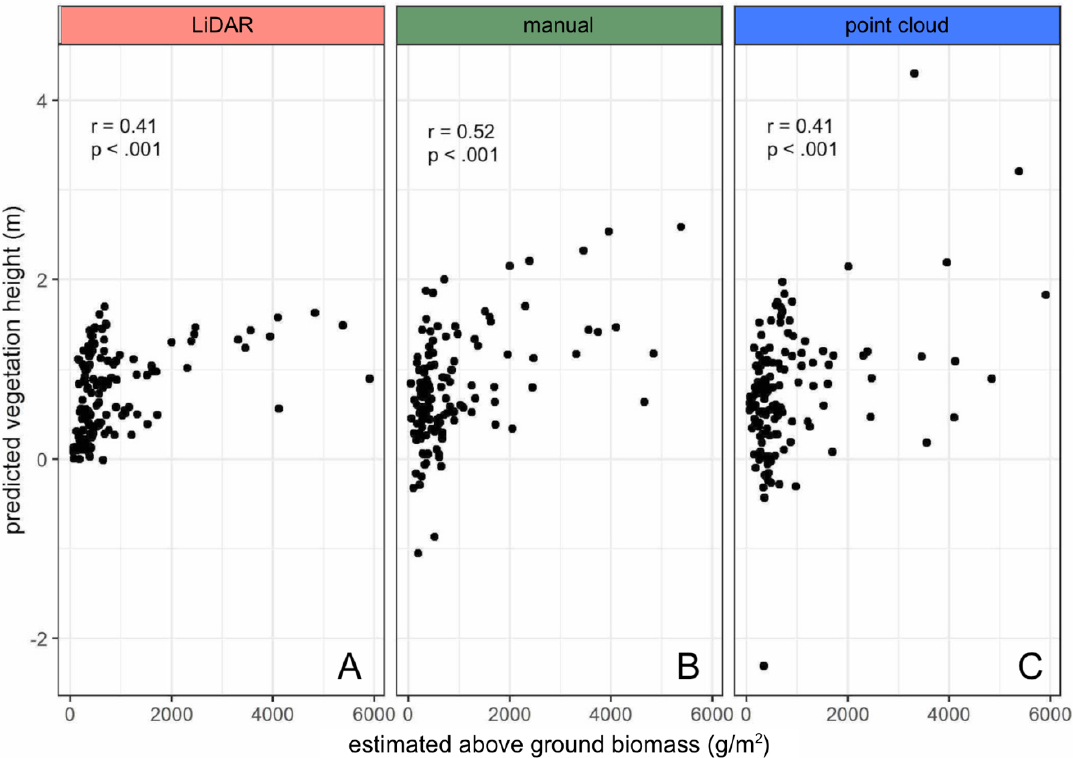
Figure 7. Predicted vegetation height and Above Ground Biomass (AGB) are significantly correlated using ( a ) LiDAR, ( b ) manual, and ( c ) point cloud terrain model construction methods. AGB is calculated from the height–weight regression developed by Davis et al., stem count and stem height measurements in the field [6]. Predicted vegetation heights are calculated from transformed drone-derived vegetation height estimates.